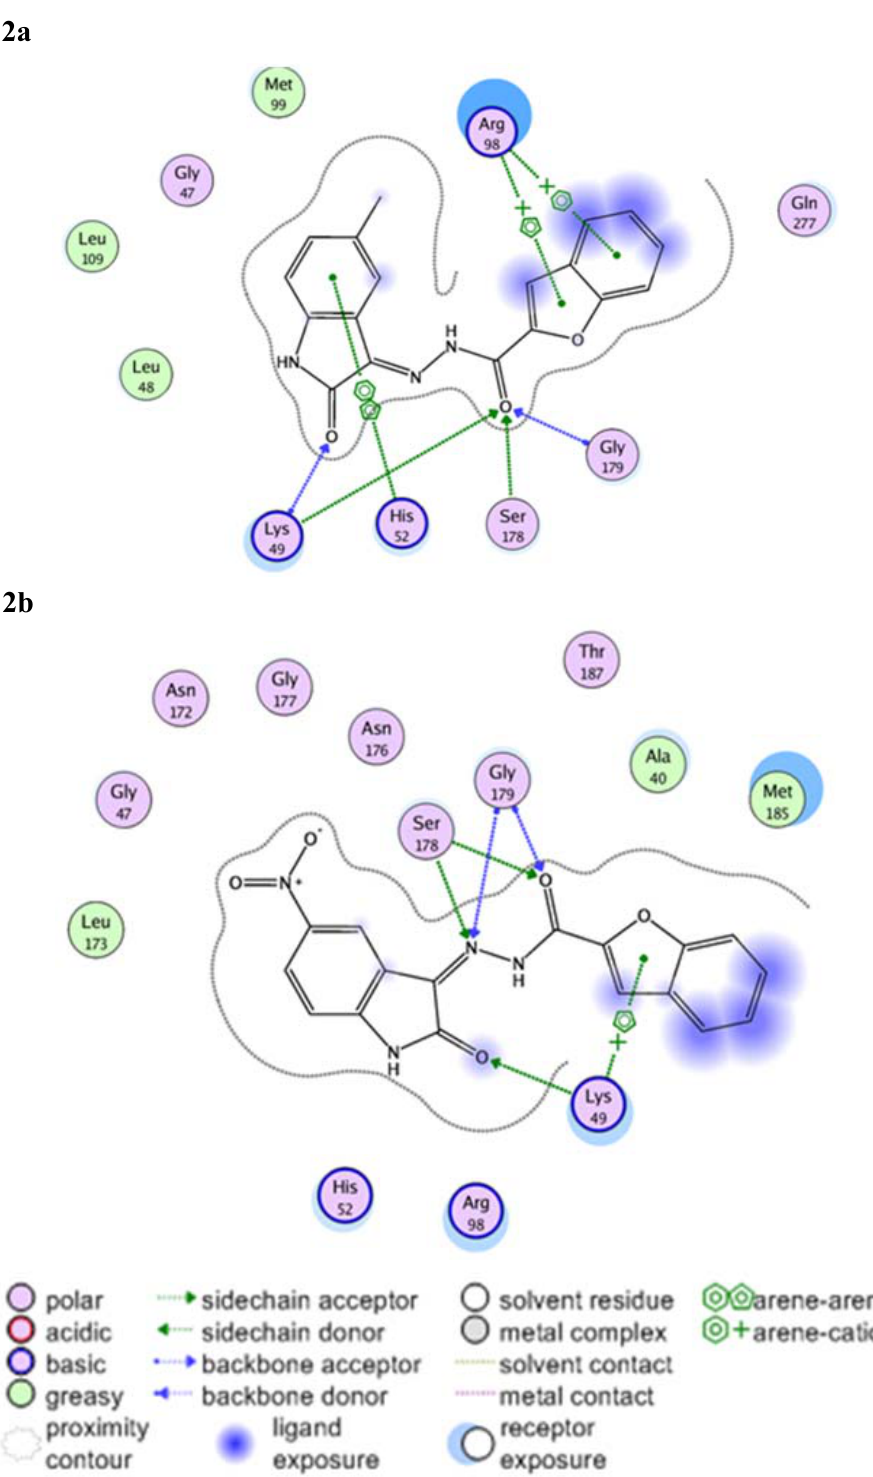
Figure 2. 2D Representation of 18 (2a) and 19 (2b) within the 3ilw active